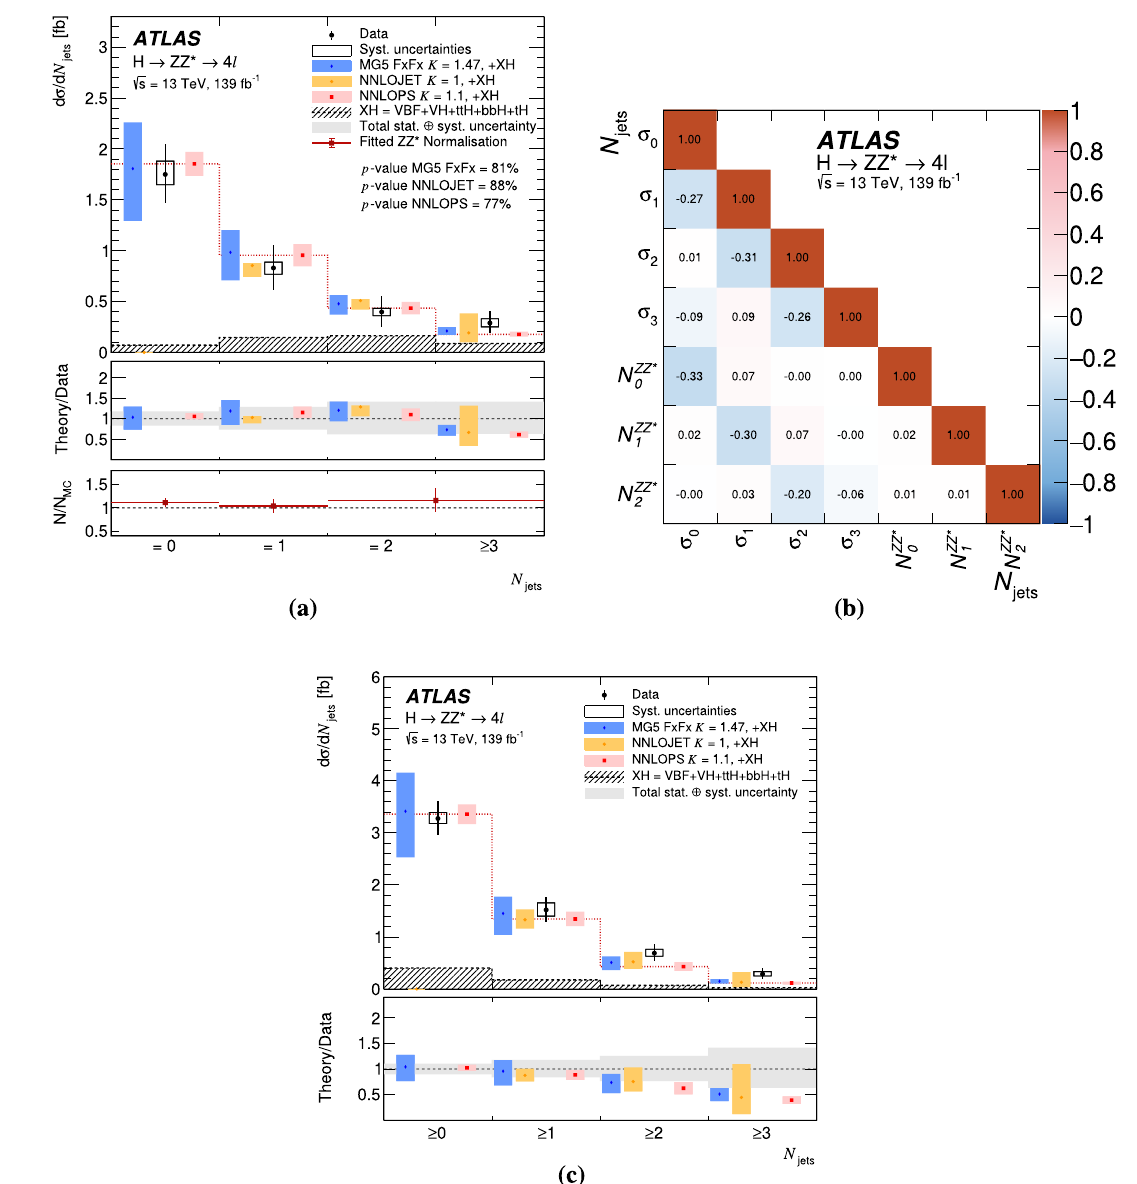
Fig. 24 Differential fiducial cross sections for a the jet multiplicity, N jets , in the selected events, and c , the inclusive jet multiplicity. In the N jets distribution in a , the first three bins are exclusive in number of jets, while the fourth is inclusive. The corresponding correlation matrix